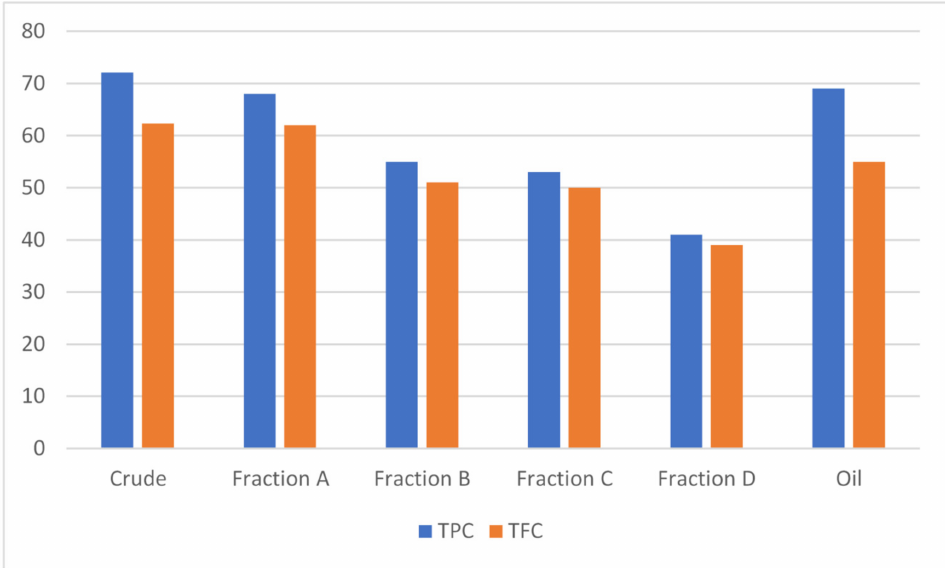
Figure 3. Total phenolic and total flavonoid content in different tested samples (crude extract, purified fractions, and oil) of A. articulata . TPC expressed as gallic acid equivalents (mg GAE)/g of dry plant sample, and TFC expressed as quercetin equivalents (mg QE)/g of dry plant sample. The data are represented as mean ± SEM, n =